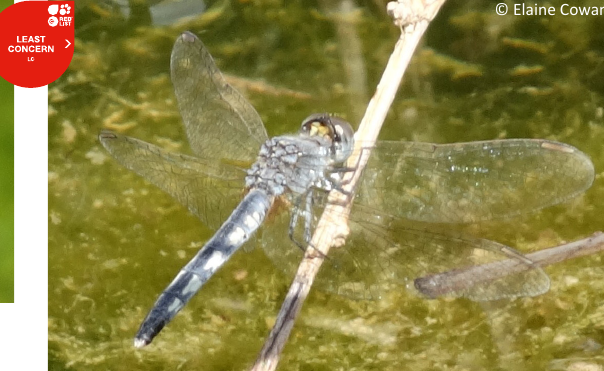
Image 23. Female Diplacodes lefebvrii resting after egg laying, 16 November 2013. Pale abdomen with heavy black markings. Small yellowish-brown patch at hindwing base.